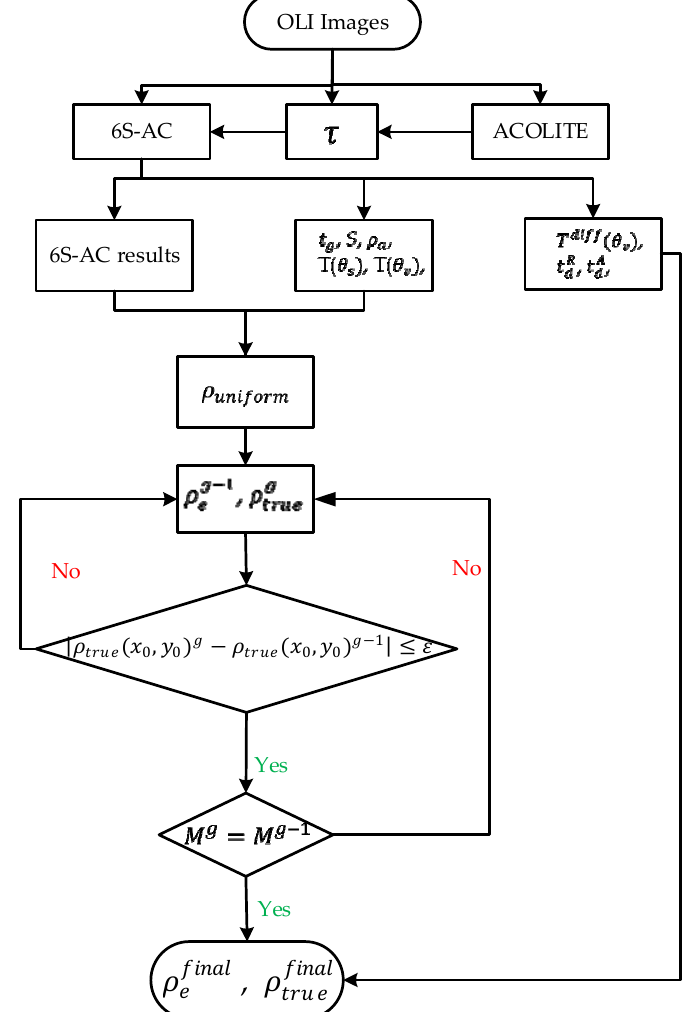
Figure 2. F lowchart of